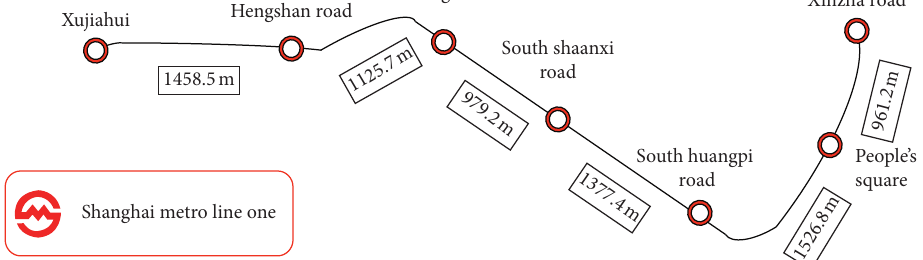
Figure 4: Structure of decision network.